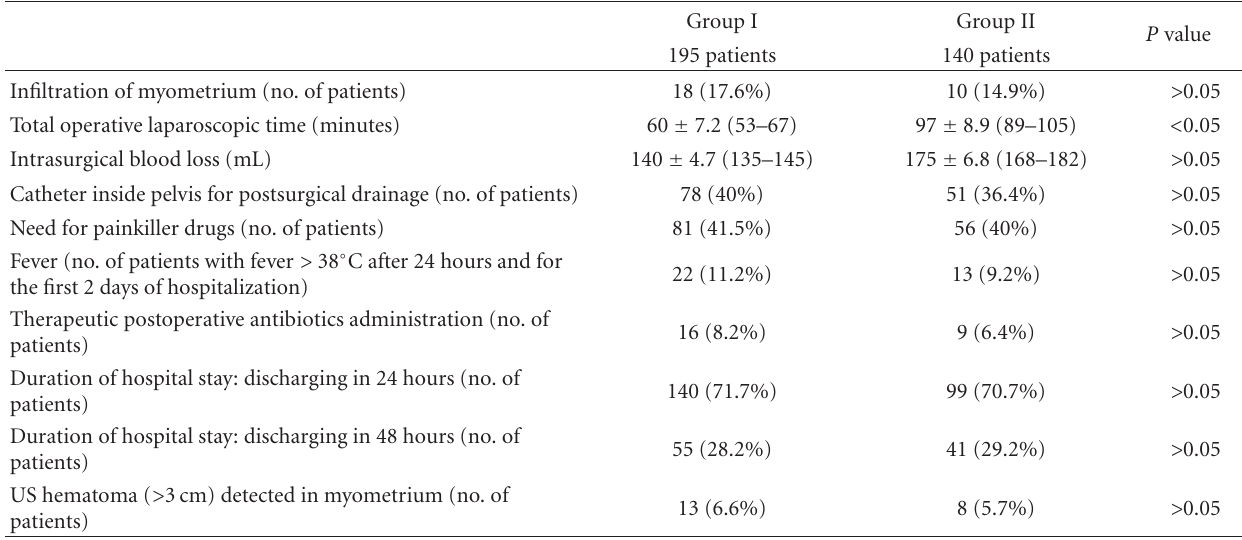
Table 2: Myoma and surgical procedure outcome of the study participants.